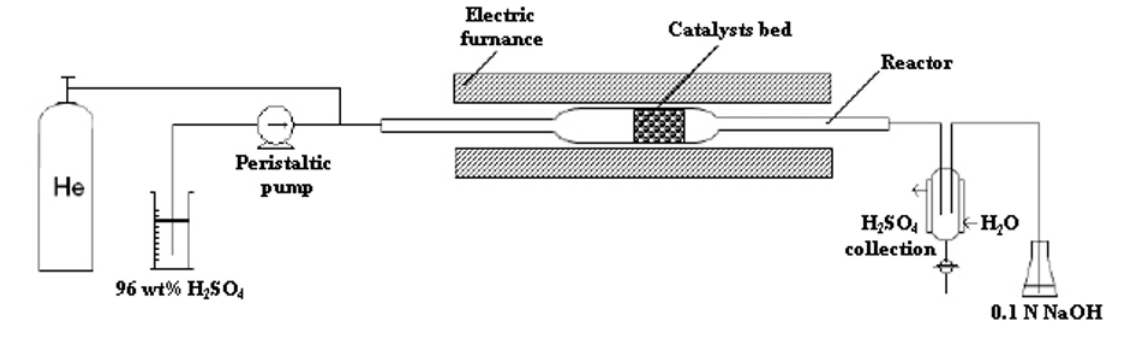
Figure 1. Schematic diagram of the experimental